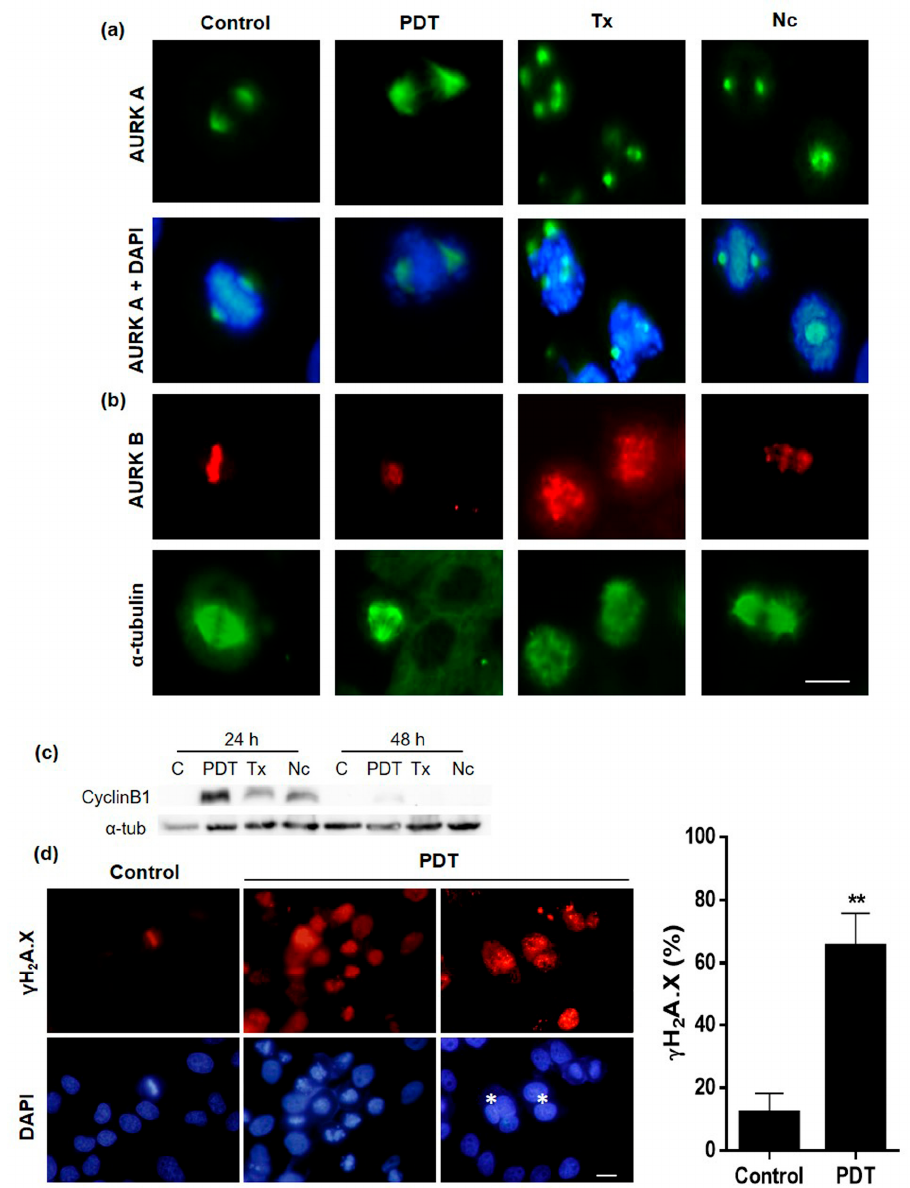
Figure 6. Localization and expression of proteins involved in cell division. ( a ) Localization of AURK A 24 h after treatment of PDT, Tx and Nc; the protein appears situated at the centrosome level. ( b ) Localization of AURK B after 24 h treatment of PDT, Tx and Nc; the protein was observed at chromosome level. ( c ) WB analyses of cyclin B1 and α -tubulin 24 and 48 h after the treatments. ( d ) Representation of positive HeLa cells by IF of γ H 2 A.X in control and after PDT; asterisk: multinucleate cells. Scale bar: 10 µ m. (** p < 0.01).